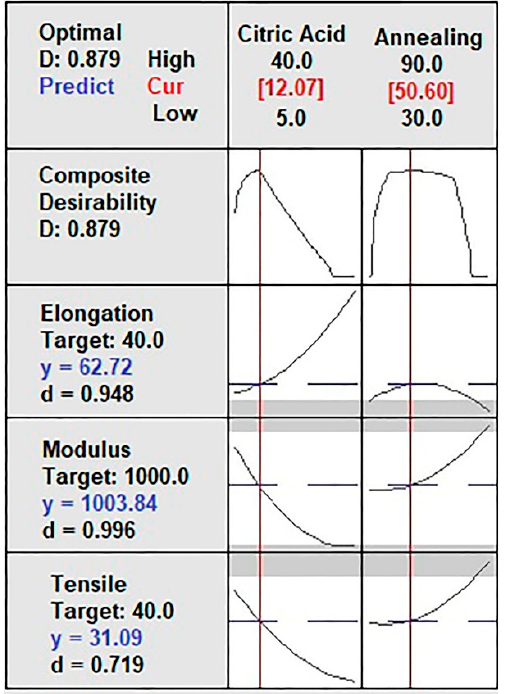
Figure 4. Optimized model solution for mechanical properties of the film.